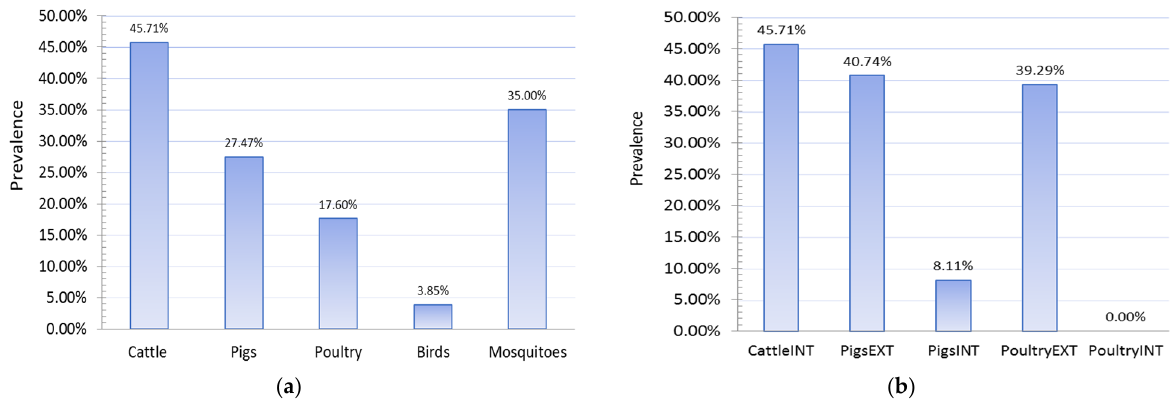
Figure 7. Seroprevalences showing ( a ) PCR detection of West Nile fever (WNV) in wild animals and mosquitoes and ( b ) WNV infection in domestic animals, 2018. INT—intensive farm production; EXT—extensive production on rural holdings.